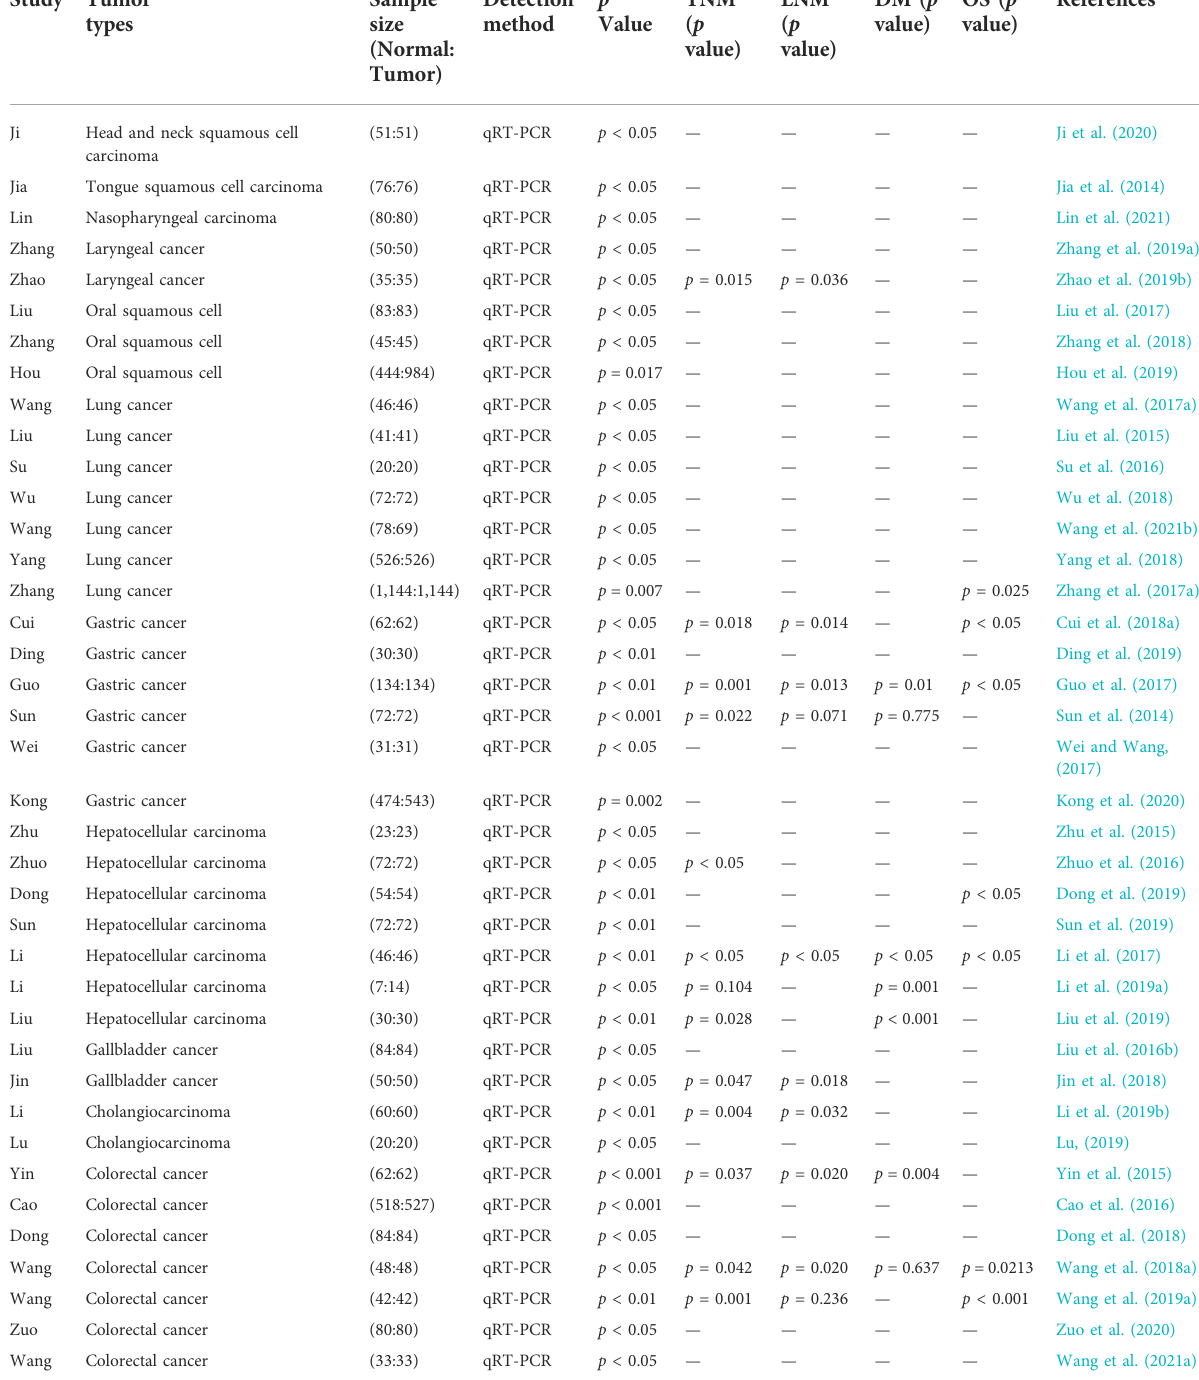
TABLE 2 Features of the studies included in this review of respiratory and digestive system